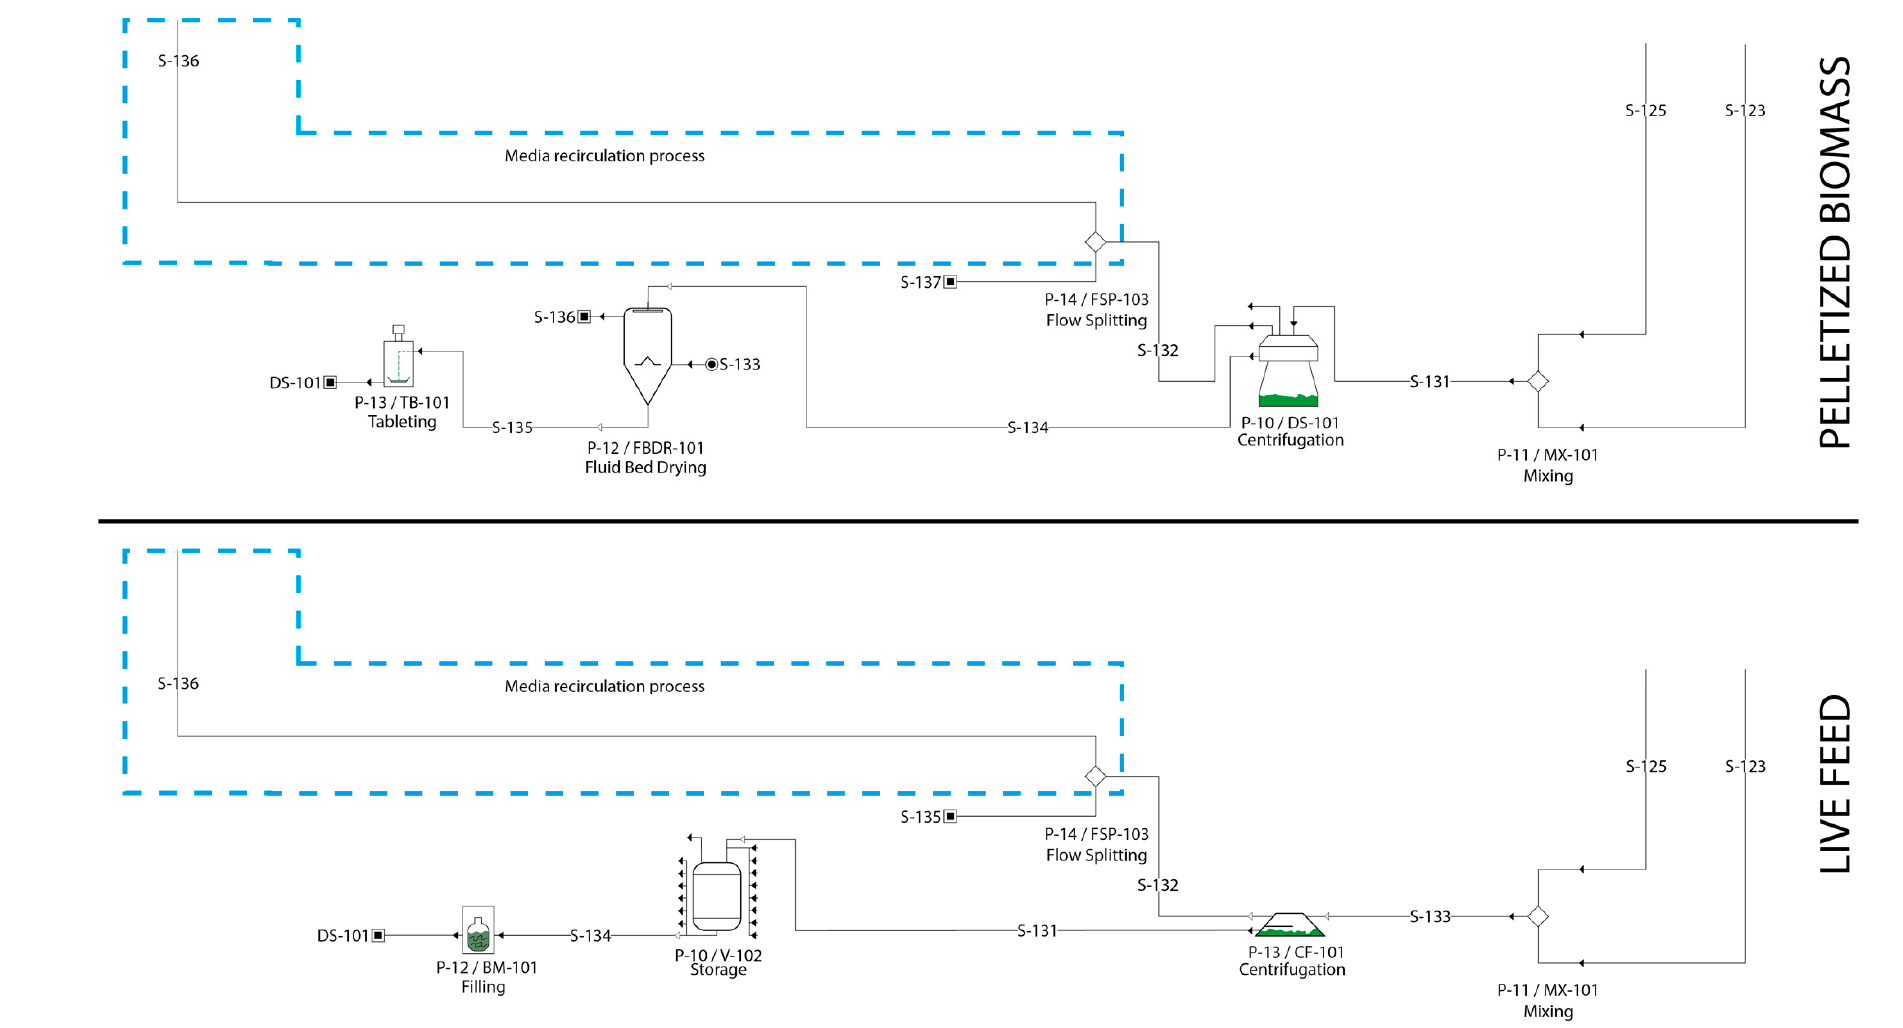
Figure 5. Flow diagram of the downstream process of pelletized biomass and live feed from Chlorella sp.